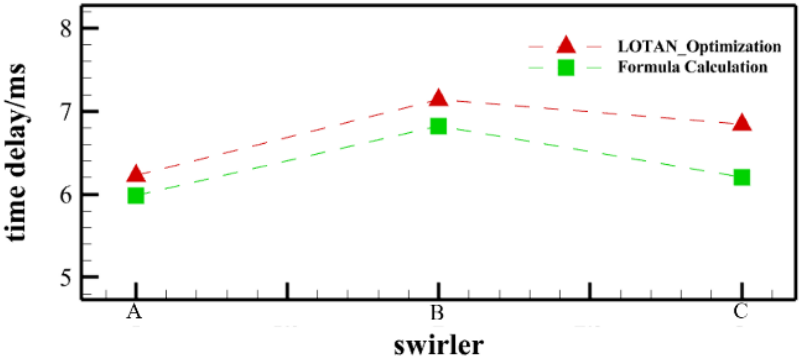
Figure 16. Comparison of LOTAN optimization with lag time obtained by formula calculation.